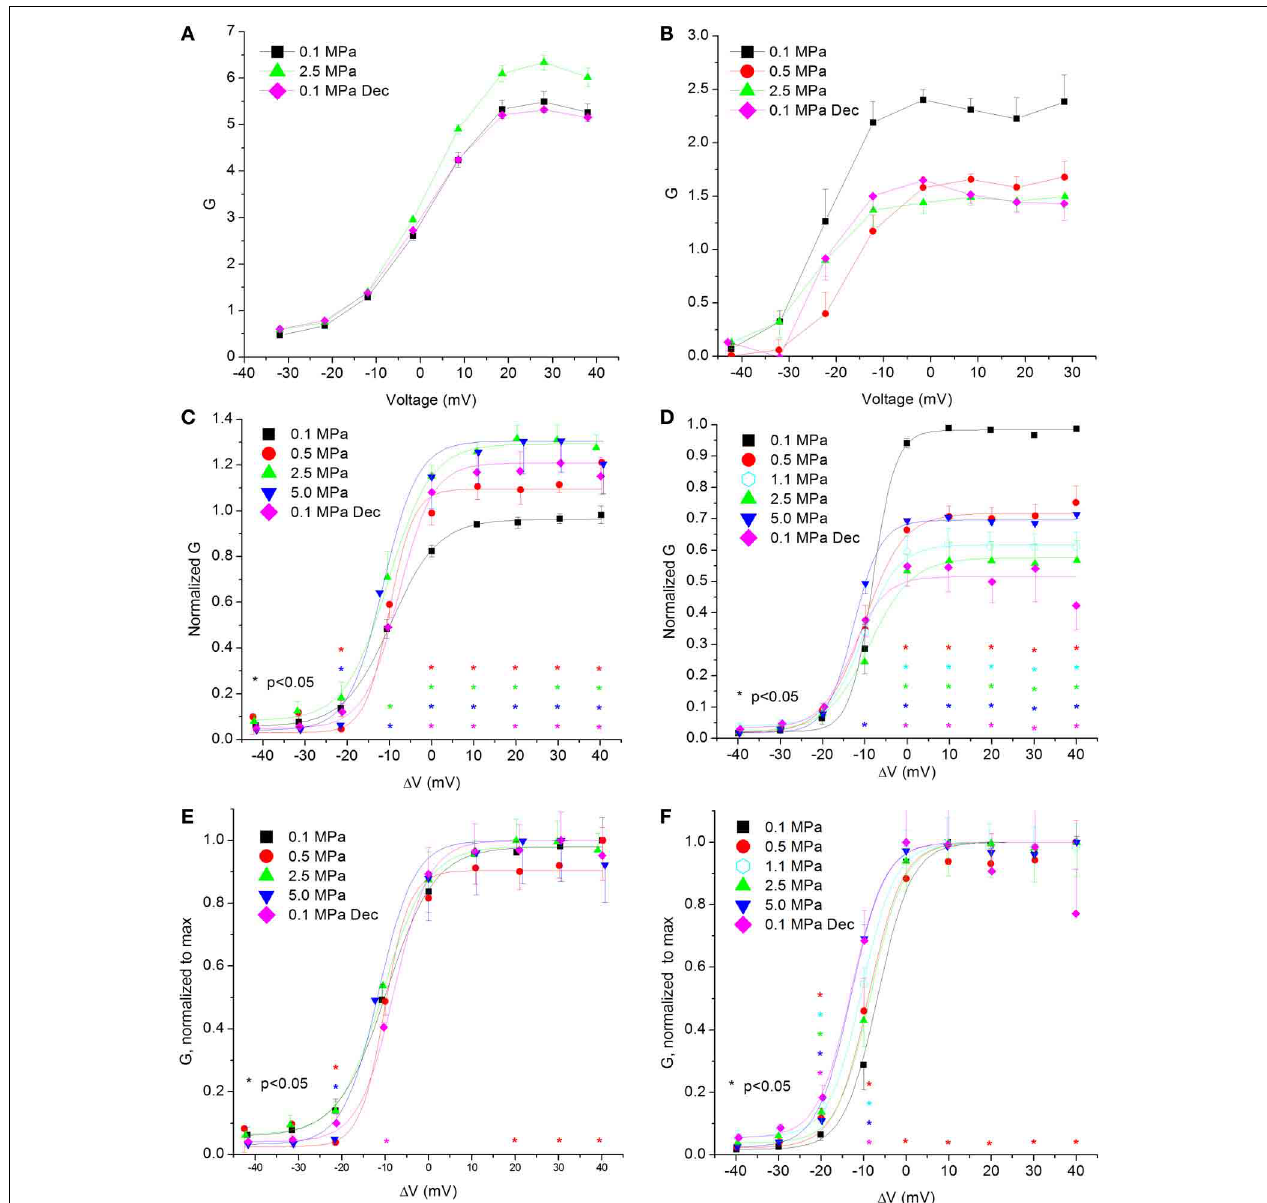
FIGURE 4 | Channels’ conductance at various pressures. (A,C,E) In Ca V 1.2 and (B,D,F) in Ca V 3.2 channels. (A,B) Conductance measured in a single oocyte. (C,D) Pooled data of the channels. (E,F) Normalized conductance: each curve is normalized to its own maximal value and corresponds to its